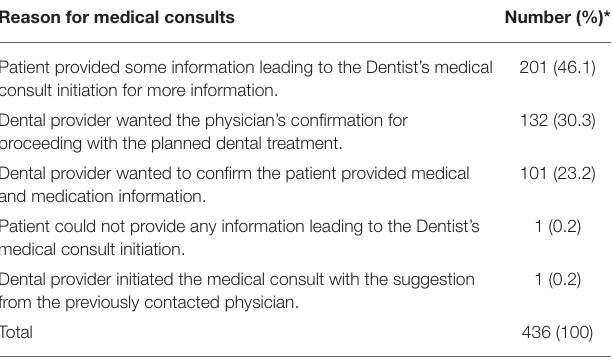
TABLE 2 | Reasons for dental providers to seek medical consults for 179